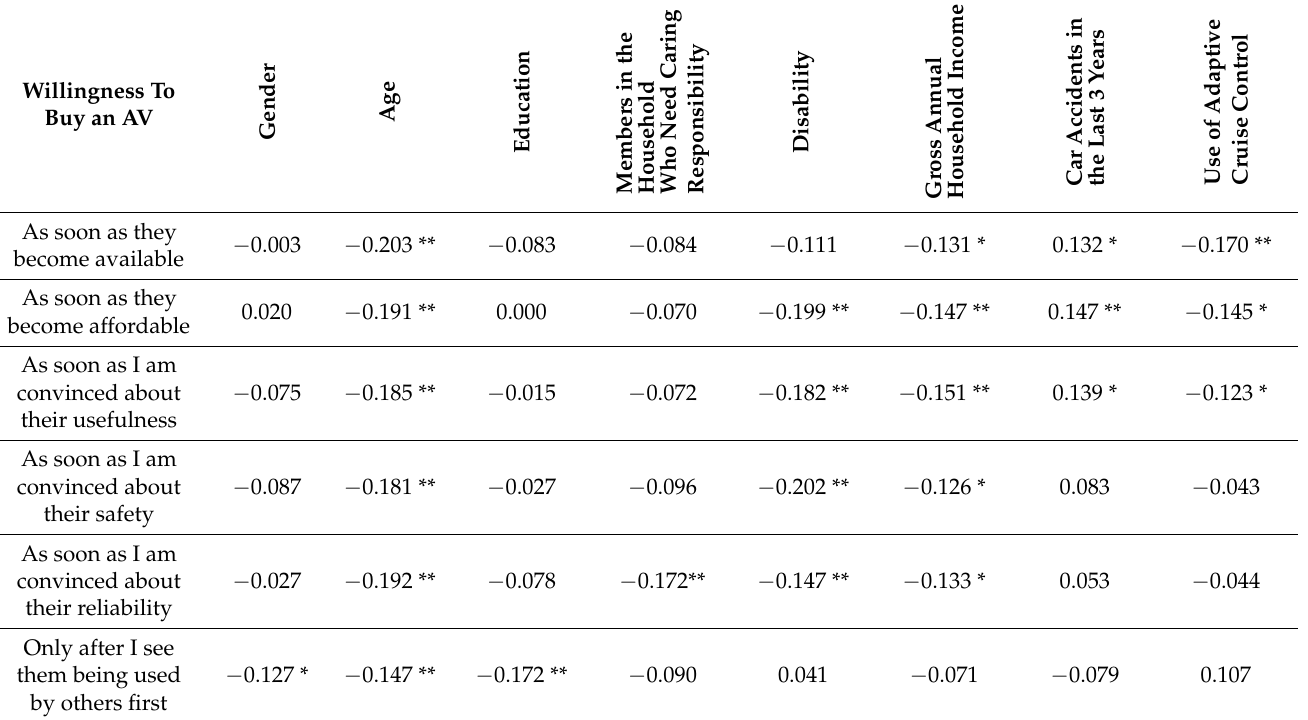
Table 9. Spearman correlation between socio-economic characteristics of the sample and willingness to buy an AV (Source: Authors’ survey